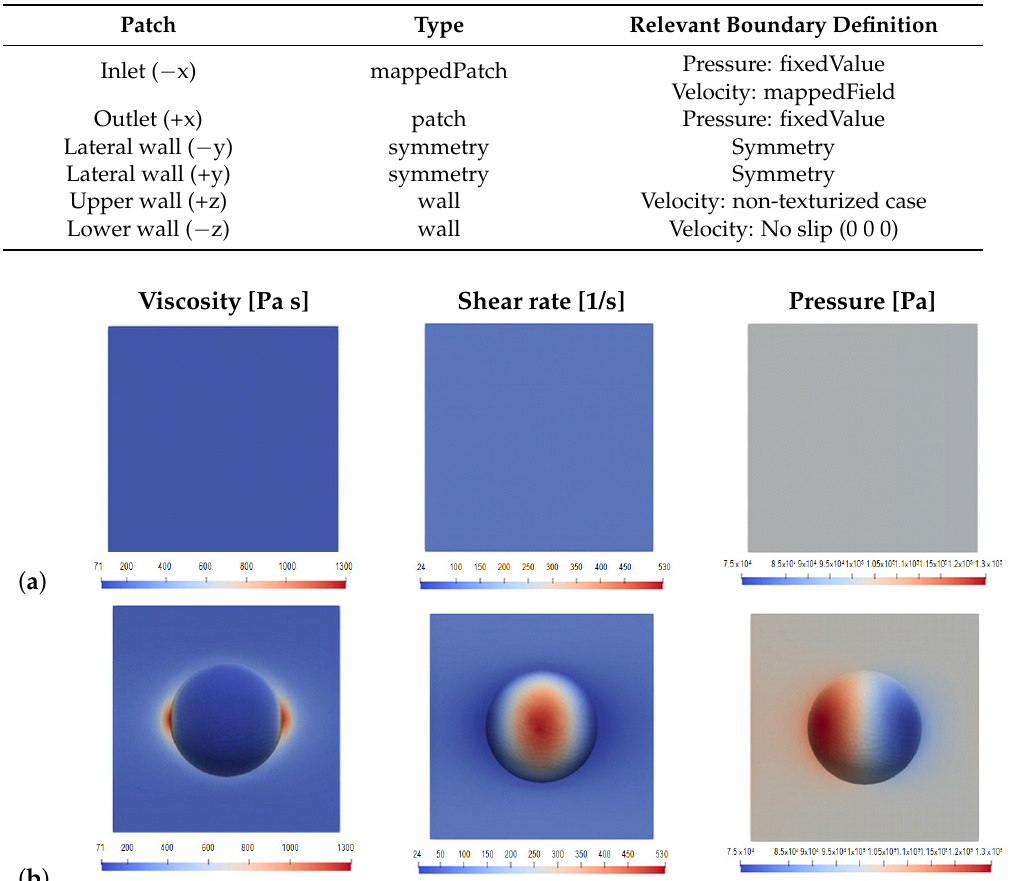
Table 4. Microscale model: boundary conditions.